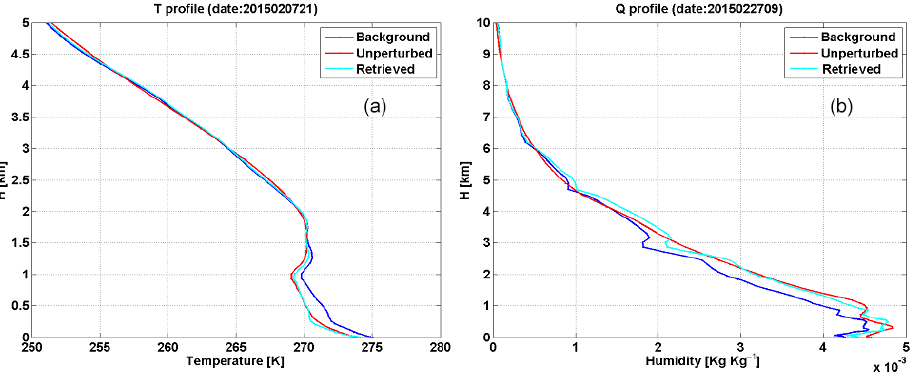
Figure 11. Temperature (a) and humidity (b) profiles of background (blue line), truth (red line), and 1D-Var retrievals (cyan line) for two clear-sky